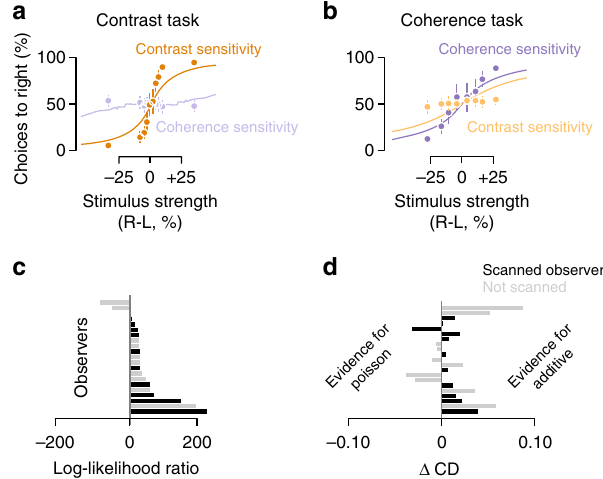
Fig. 6 Poisson vs additive noise. a , b Same conventions as Fig. 2a, b, except curves indicate the prediction of a model incorporating Poisson-like noise in which variance scales equal to response strength. c The cross-validated likelihood ratio (difference in log-likelihood) between the additive and Poisson models is shown for each observer. d The change in Tjur ’ s CD comparing the additive models against the Poisson models, a measure analogous to r 2 . Observers are sorted as in c . In c , d evidence for the Poisson model is plotted toward the left and evidence for the additive model to the